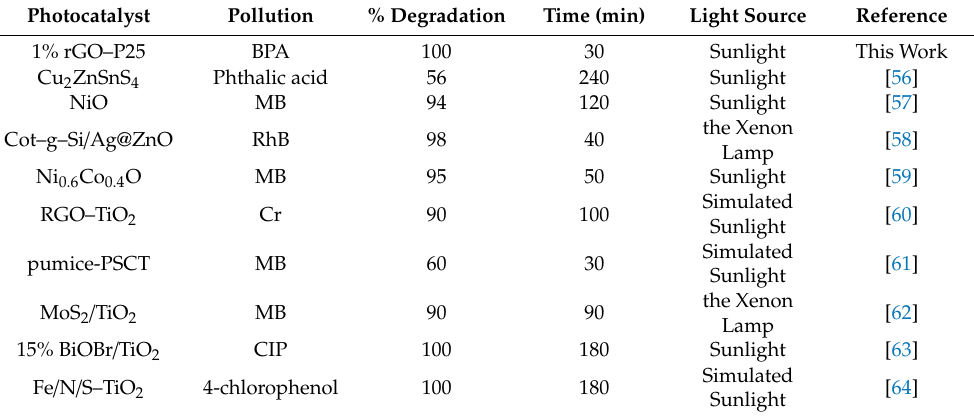
Table 2. Comparison of catalytic e ffi ciency of di ff erent photocatalysts under